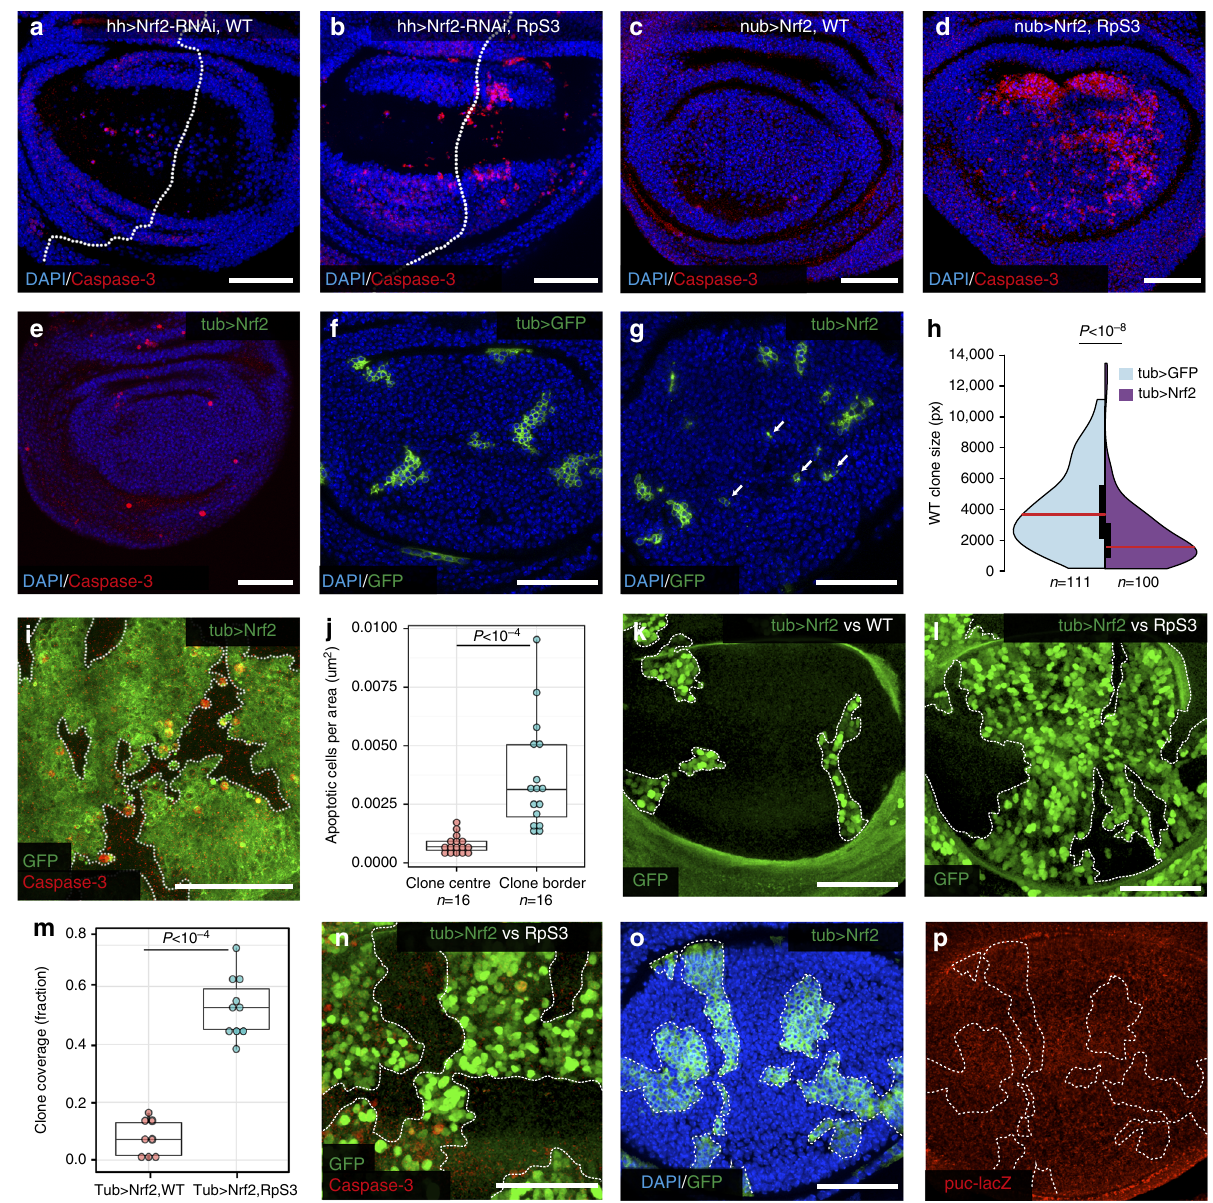
Fig. 6 Nrf2 activation is required for RpS3 + / − cell survival and is suf fi cient to confer the loser status. a , b WT ( a ) or RpS3 + / − ( b ) wing discs with knockdown of Nrf2 in the P compartment and stained with an anti-cleaved Caspase-3 antibody. Dotted line indicates the A/P boundary. c , d WT ( c ) or RpS3 + / − ( d ) wing discs overexpressing Nrf2 in the pouch, stained with an anti-cleaved Caspase-3 antibody. e Wing disc mildly overexpressing Nrf2 throughout (see genotype in methods), stained with an anti-cleaved Caspase-3 antibody. Note the absence of signi fi cant autonomous cell death (cleaved Caspase-3, red ). f , g Wing discs harbouring clones overexpressing GFP alone ( f ) or with the addition of Nrf2 ( g ) (arrows indicate instances of clone fragmentation). h Size distributions represented as split-violin plots of clones from genotypes as in f , g . P -values calculated using Wilcoxon rank sum test. i Wing discs harbouring clones overexpressing GFP and Nrf2 and stained with an anti-cleaved Caspase-3 antibody ( red ). j Quanti fi cation of the density of apoptotic cells in the clone centre or at the clone boundaries, i.e., within a 2-cell diameter of the clone periphery, for discs of the same genotype as in i ; each dot represents a single wing disc. P values calculated using paired sample t -test. k , l wing discs with GFP-labelled Nrf2 overexpressing clones (otherwise wild-type) surrounded by WT ( k ) or by RpS3 + / − ( l ) cells (see genotypes in methods). m Quanti fi cation of GFP-positive clone area as a fraction of the entire pouch region in wing discs from k , l . Each dot represents one wing disc and the P value is according to the Welch t -test. n Wing disc with GFP-labelled Nrf2 overexpressing clones (otherwise WT) surrounded by RpS3 + / − cells as in l and stained with anti-cleaved Caspase-3 ( red ). Note the absence of cell death at clonal boundaries (outlined with white dotted line ). o , p Activity of the puc -LacZ reporter ( red , p ) in WT wing discs harbouring GFP-labelled clones that overexpress Nrf2 ( green , o ) at same levels as in i . Detailed genotypes for each fi